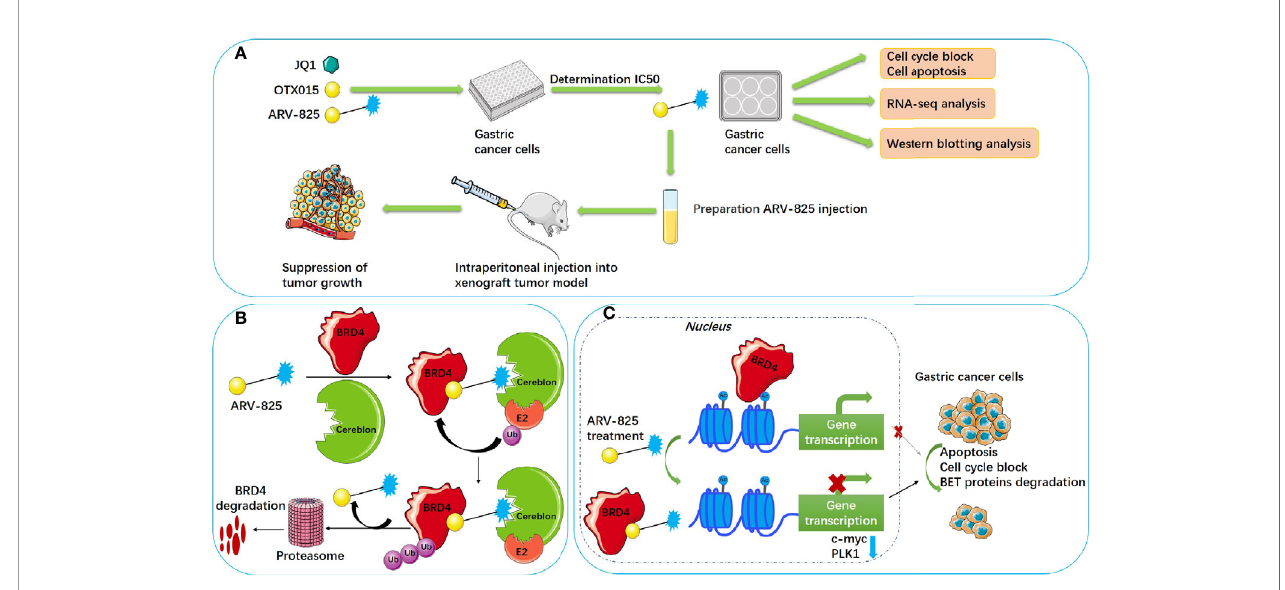
SCHEME 1 | Schematic illustration of ARV-825 treating gastric cancer. (A) Technical roadmap of ARV-825 treating gastric cancer. (B) Schematic diagram of ARV-825 degrading BRD4. (C) Molecular mechanism of ARV-825 treating gastric cancer. Ub, ubiquitin; E2, ubiquitin-conjugating enzyme; cereblon, E3 ubiquitin ligase; Ac, acetylation modi fi cation